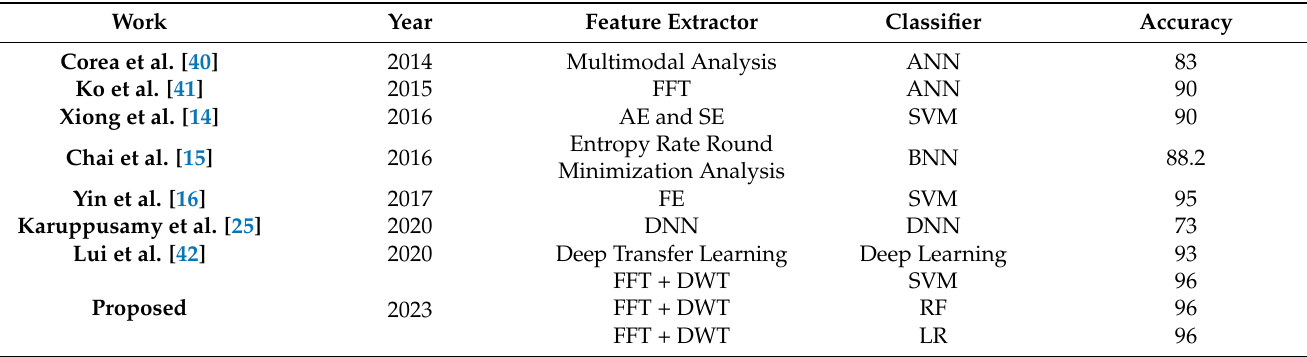
Table 8. Brief Comparison among The Proposed Models and Works in The Literature.